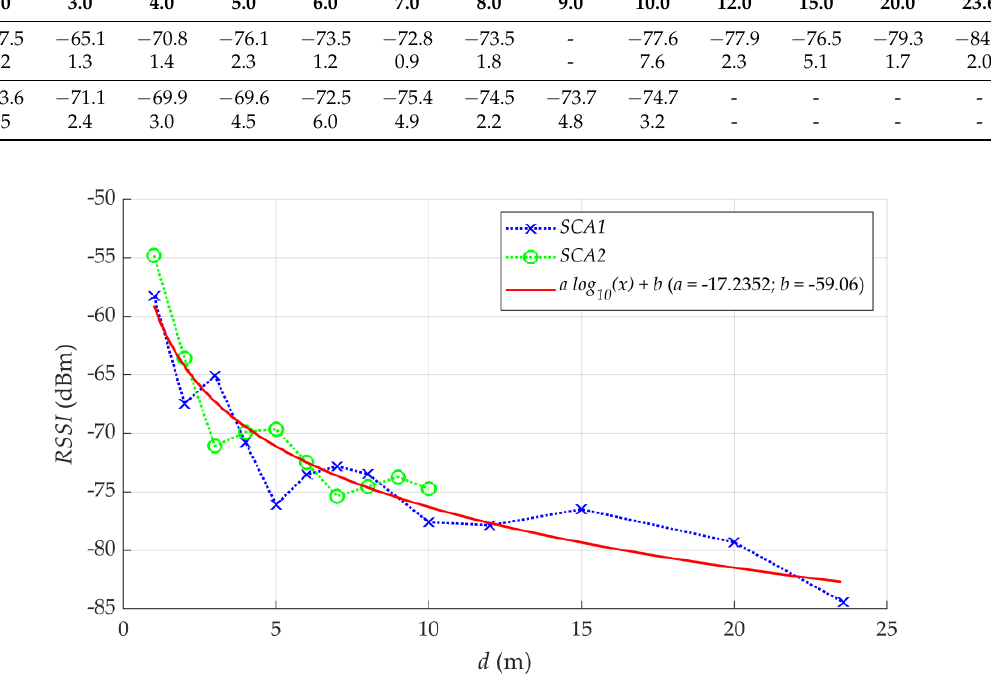
Figure 9. Changes in the mean value of the RSSI series of measurements depending on the distance in the SCA1 and SCA2 test scenarios and the logarithmic Model (2).